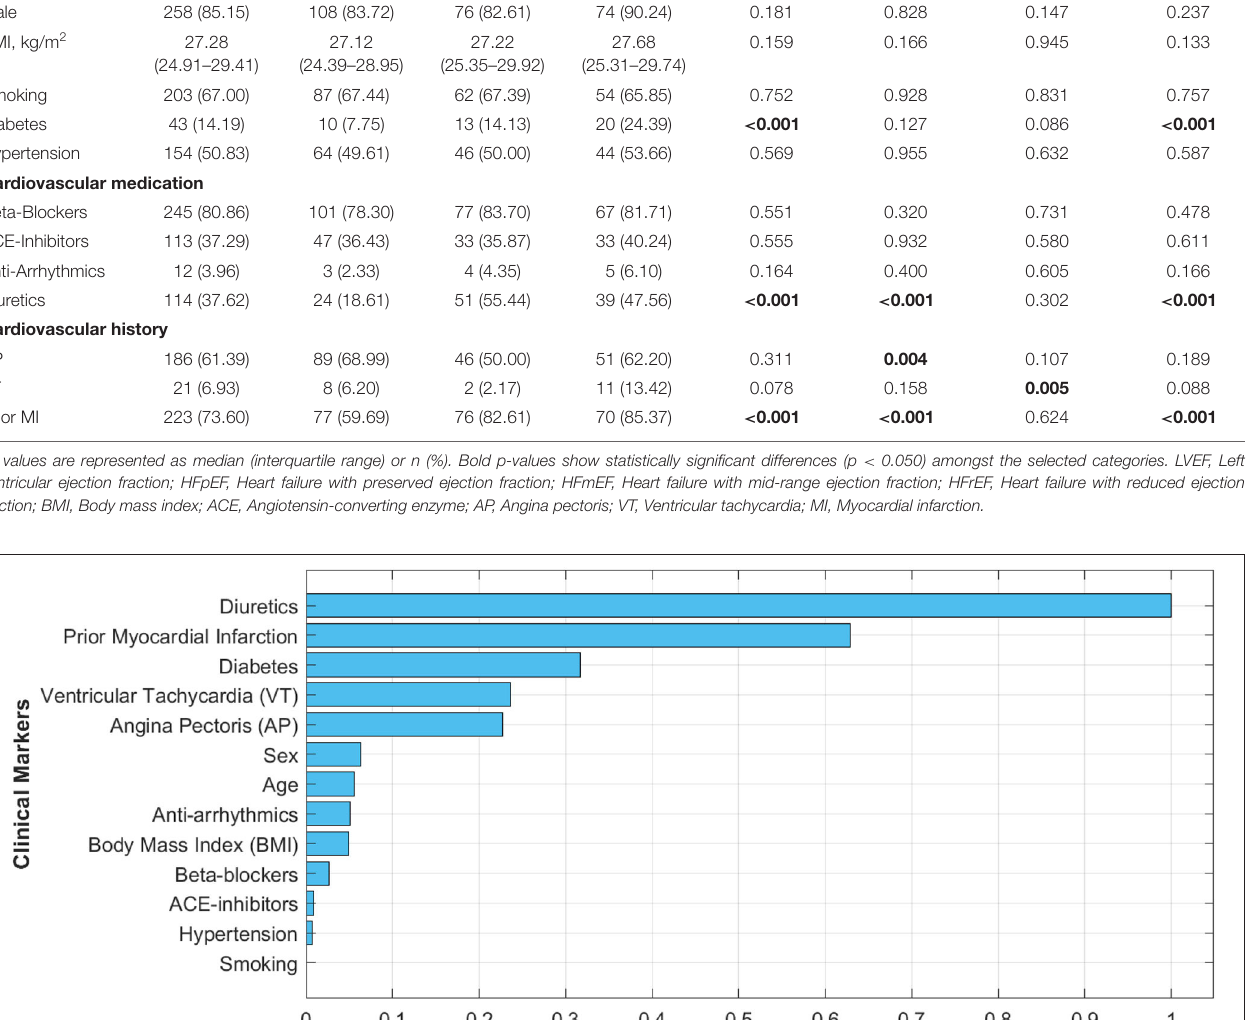
difference of 0.39 ± 11.61 between the estimated and original LVEF levels. Additionally, the correlation plot was skewed positively with an overall coefficient of 0.85 ( Figure 4C ). The classification model developed for this project ( Figure 5A ) efficiently predicted each LVEF category with a precision